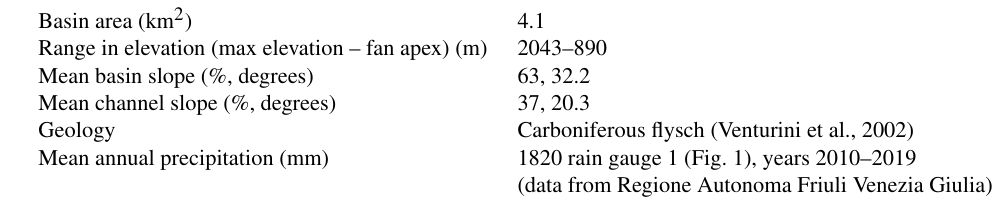
Table 1. Basic characteristics of the Moscardo basin.